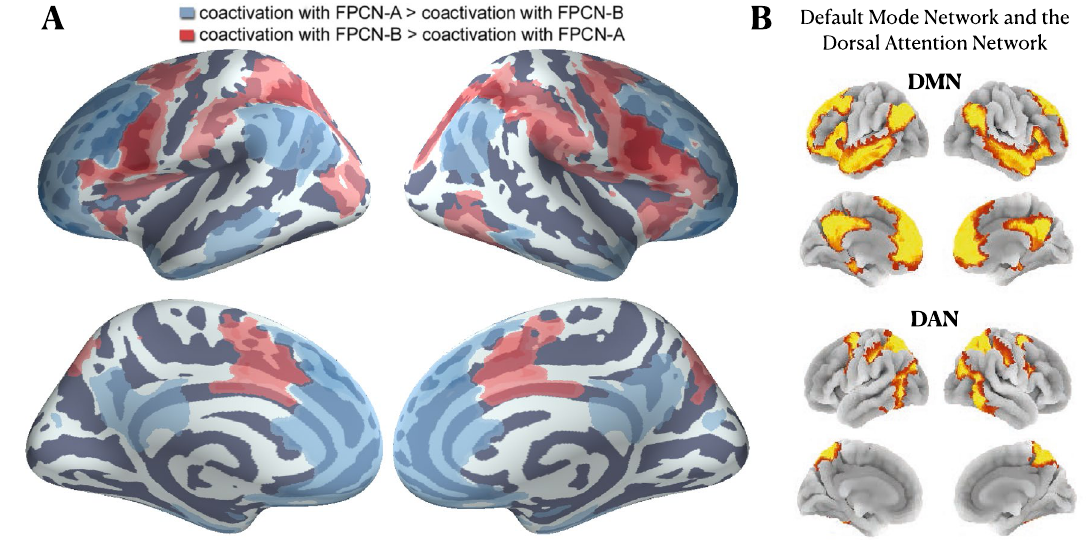
Figure 5. ( A ) DiFuMo-256 components that are more likely to coactivate with one FPCN sub- network than the other. In blue, we depict regions exhibiting a greater probability of coactivation with FPCN-A. In red, we depict regions exhibiting a greater probability of coactivation with FPCN-B. The absolute difference between region coactivation probabilities is defined as � = P [ RegionReported ( r ) | NetworkReported ( FPCN-A ) ]− P [ RegionReported ( r ) | NetworkReported ( FPCN-B ) ] . A likelihood-ratio test and an FDR correction ( α = 0.05 ) for multiple comparisons are used to identify regions that exhibit significant coactivation with either network before estimating (cid:31) . ( B ) The default mode network (DMN) and the dorsal attention network (DAN) from the 7-Network atlas of Yeo et al. 2011. DMN regions are more likely to coactivate with FPCN-A, whereas DAN regions are more likely to coactivate with